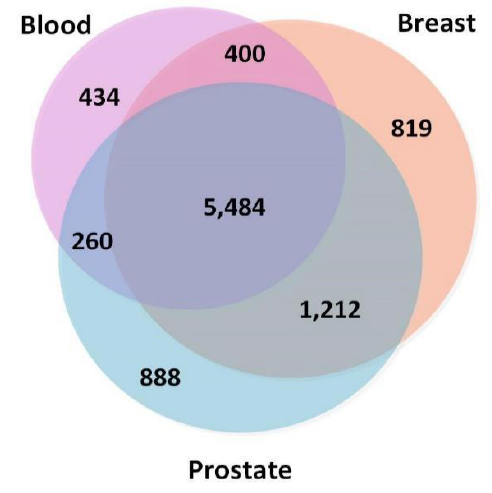
Figure 2. Numbers of overlapping genes in three tissue-specific networks (blood, breast, and prostate).